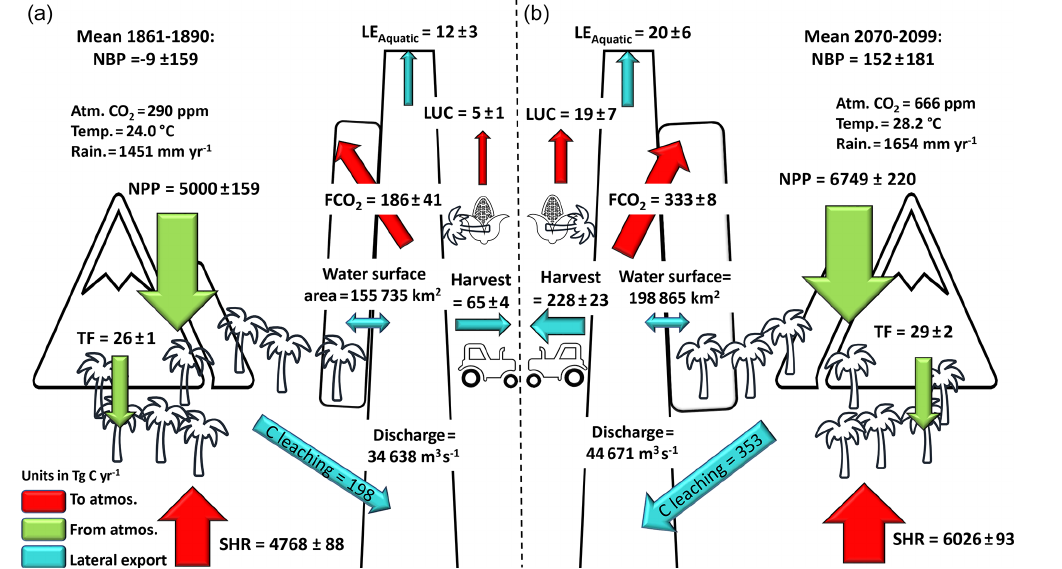
Figure 10. Annual C budget (NBP, net biome production) for the Congo Basin for (a) 1861–1890 and (b) 2070–2099, simulated with ORCHILEAK; NPP is terrestrial net primary productivity, TF is throughfall, SHR is soil heterotrophic respiration, FCO 2 is aquatic CO 2 evasion, C leaching is C leakage to the land–ocean aquatic continuum (FCO 2 + LE Aquatic ), LUC is the flux from land use change, and LE Aquatic is the export C flux to the coast. Range represents the standard deviation